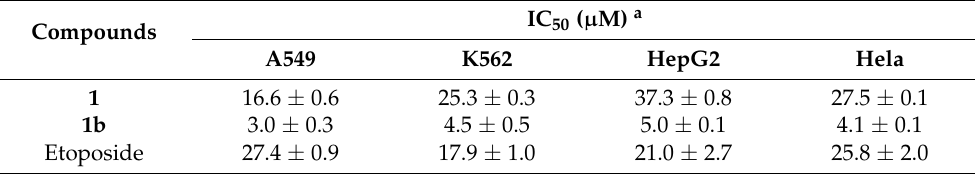
Table 1. In vitro cytotoxic effects of compounds 1 and 1b on four cancer cell lines. Compounds